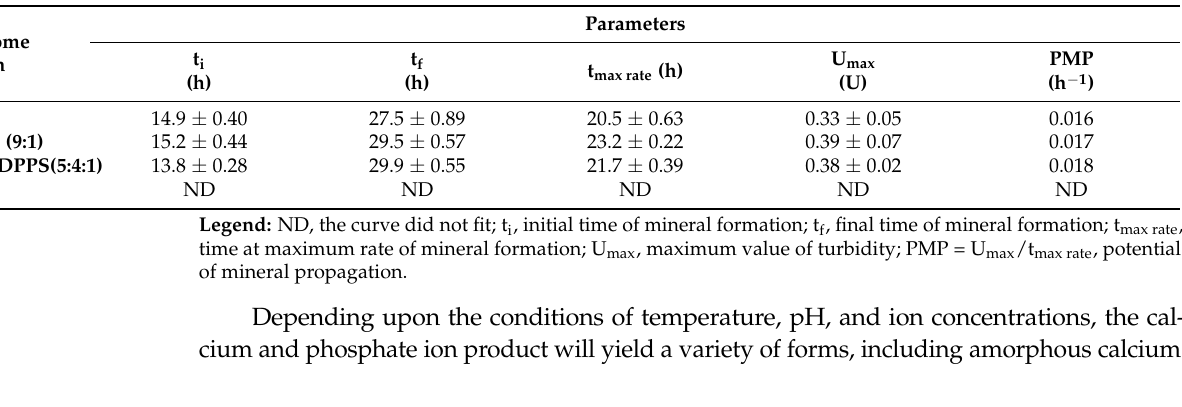
Table 3. Kinetic parameters of the nucleation process obtained from the mineralization curves for proteoliposomes and AnxA6 in solution (control), after 30 h of assay in SCL medium containing PS–CPLX in the presence of type-I collagen. Data are reported as the mean ± SD of triplicate measurements of three different proteoliposome